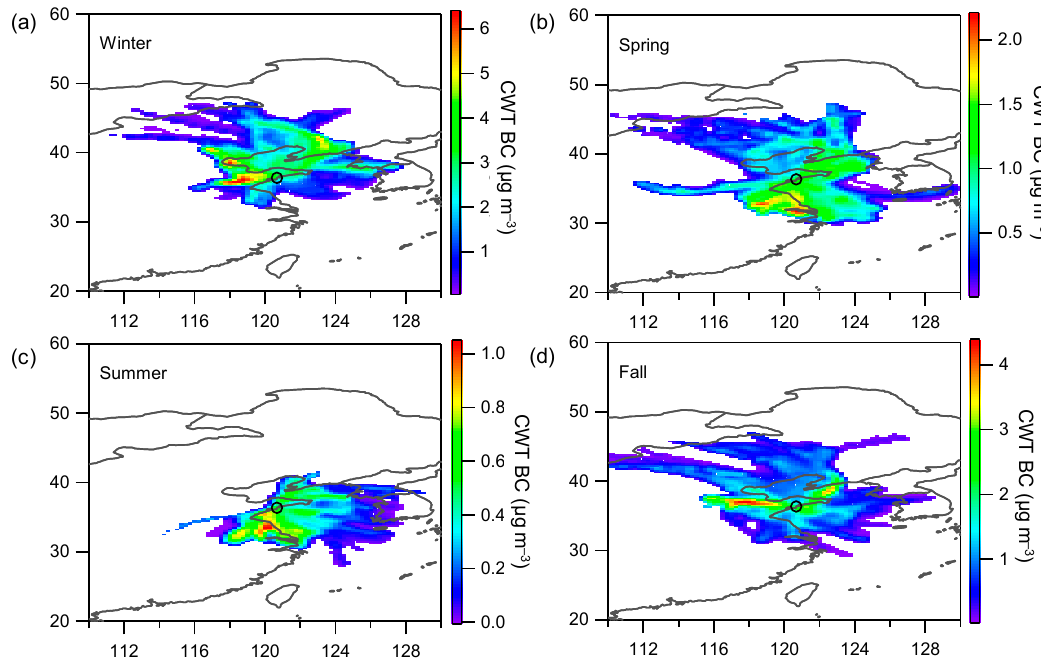
Figure 9. Maps of the concentration weighted trajectories of BC in the four season: ( a ) winter, ( b ) spring, ( c ) summer, and ( d ) fall, respectively. The color bar on the right represents the CWT BC mass concentration in μ g·m − 3 .